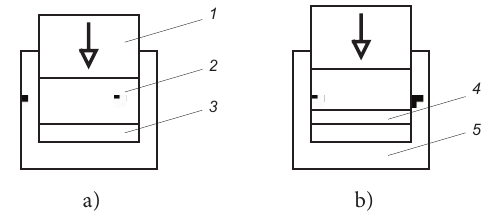
Figure 1. Production of profiles of a) fibrous and b) fibrous- mesh structures; 1 – clamping stamp; 2 – copper fibers;